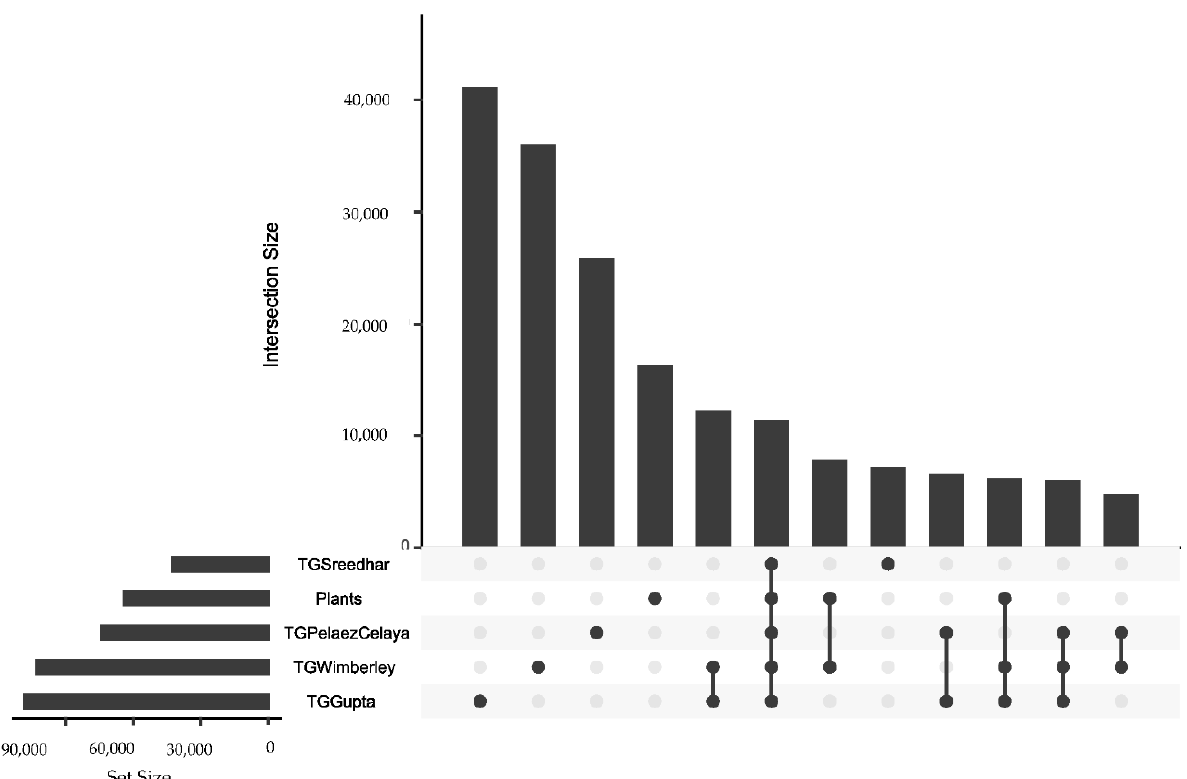
Figure 3. UpSet plot visualizing orthology among assemblies. Each transcript sequence set is internally clustered; its size after clustering is represented by the bar size in the lower left. The sizes of intersections (sets of sequences found in multiple assemblies) are shown by bars in the main plot, sorted with the most common intersections first. The beads connected by lines below report which assemblies contain each set of homologous sequences. “Plants” represents the transcript sequence set published by Wimberley et al., while “TGWimberley” represents a new Trinity assembly of the Wimberley FASTQs, pruned by TrimGalore.